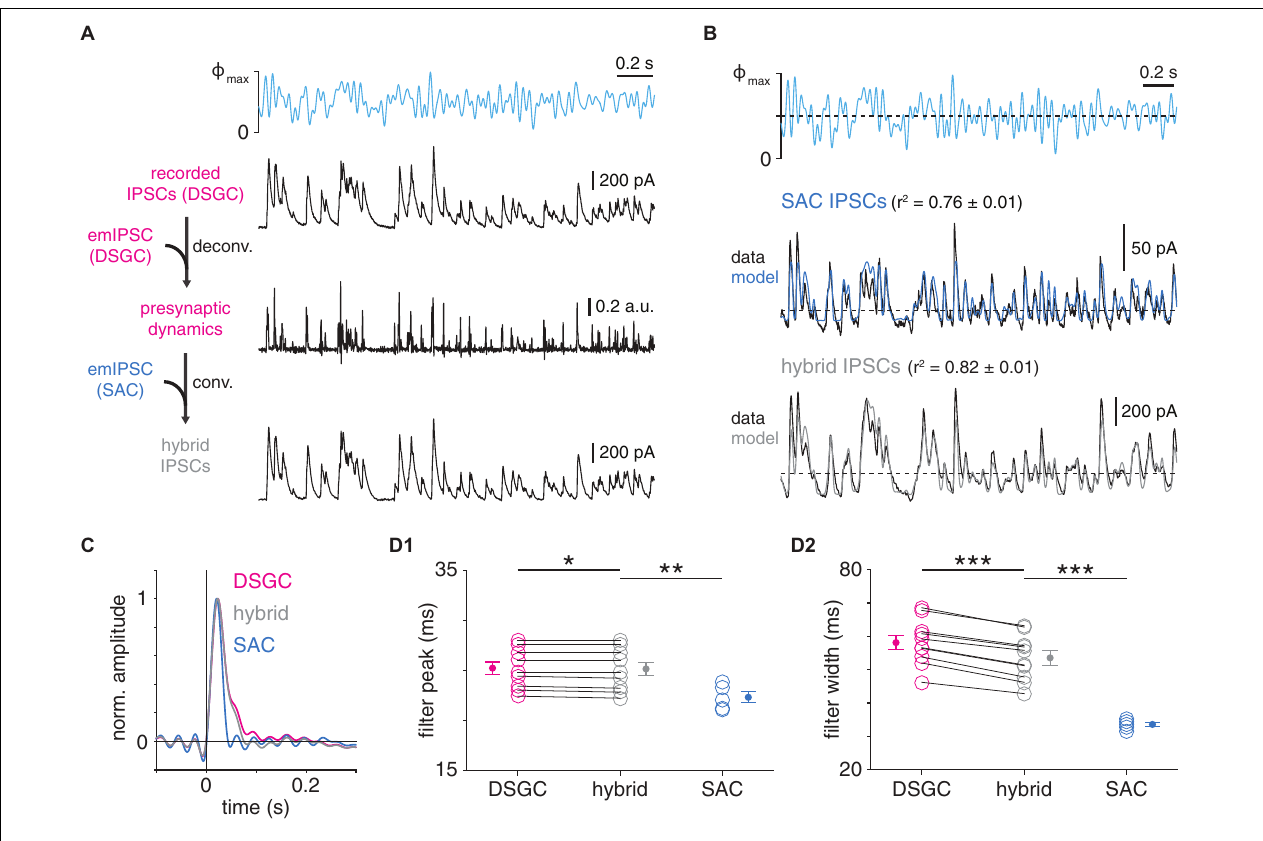
FIGURE 6 | Postsynaptic dynamics only partially explain postsynaptic cell type-specific filtering at GABAergic SAC synapses. (A) Protocol for generation of hybrid IPSCs. Wiener deconvolution of ON-OFF DSGC IPSCs removes the contribution of postsynaptic dynamics (DSGC emIPSC) to estimate presynaptic release dynamics. The result is convolved with an estimate of SAC → SAC postsynaptic dynamics (SAC emIPSC) to generate hybrid IPSCs. (B) Comparison of recorded and corresponding hybrid IPSC responses to optogenetic WN stimulation of SACs. Top , optogenetic WN stimulus. Maximum light intensity ( (cid:56) max ), 4.8 × 10 17 Q cm − 2 s − 1 . Mean responses (black) and LN models (colored) for IPSCs recorded in an ON SAC ( top ) and hybrid IPSCs combining (1) presynaptic dynamics of GABAergic transmission to the same ON-OFF DSGC as above with (2) postsynaptic dynamics of GABAergic transmission to ON SACs ( bottom